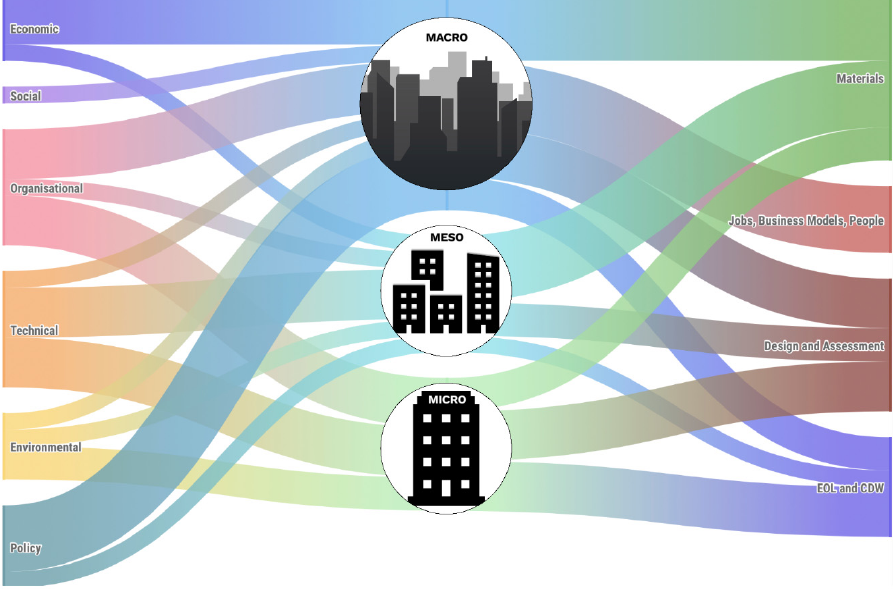
Figure 4. Intensity, dimensions and boundaries of the strategies to CE adoption in the existing build- ing